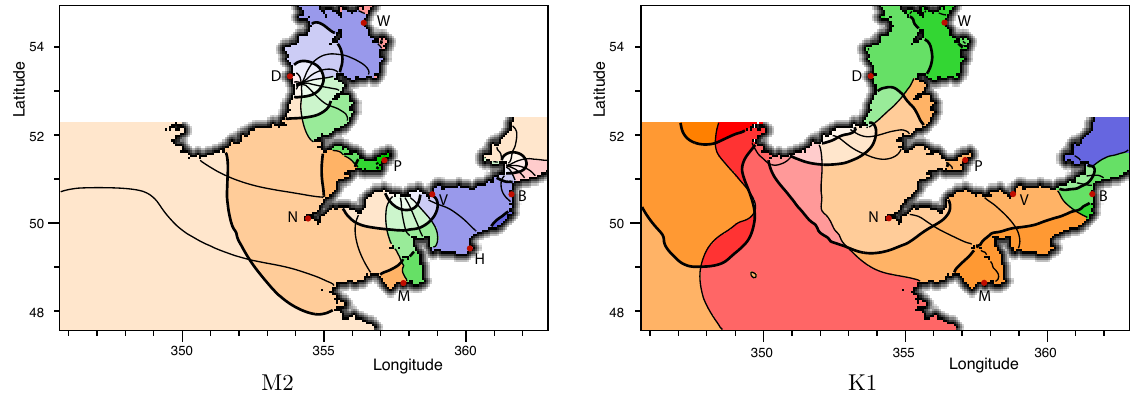
Fig. 2. The model M2 and K1 tides. Thick lines are contours of amplitude; M2 at 0.5m, 1.5m and intervals of 1.5m; K1 at 1cm, 2.5cm and intervals of 2.5cm. In the southwest the M2 amplitude is 0.87m and K1 is 6.4cm. Thin lines are contours of phase at intervals of 30 ◦ . Colours denote phase quadrant (red, 0–90 ◦ ; orange, 90–180 ◦ ; green, 180–290 ◦ ; blue, 270–360 ◦ ) with the more intense colours denoting higher amplitudes. The tide gauge stations are D, Dublin; W, Workington; P, Portishead; N, Newlyn; V, Ventnor; B, Boulogne; H, Le Havre; M, St.